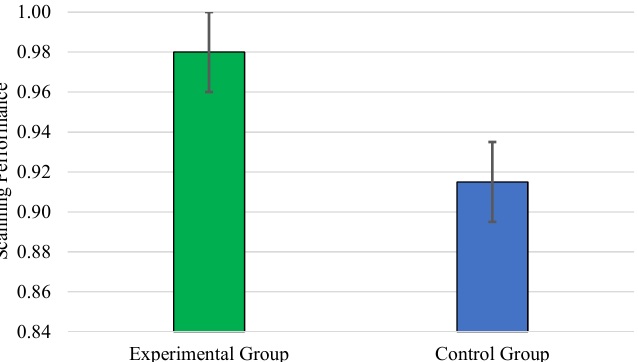
Figure 4. Scanning performance of the AR and conventional training groups in AR post-test. Error bars represent standard